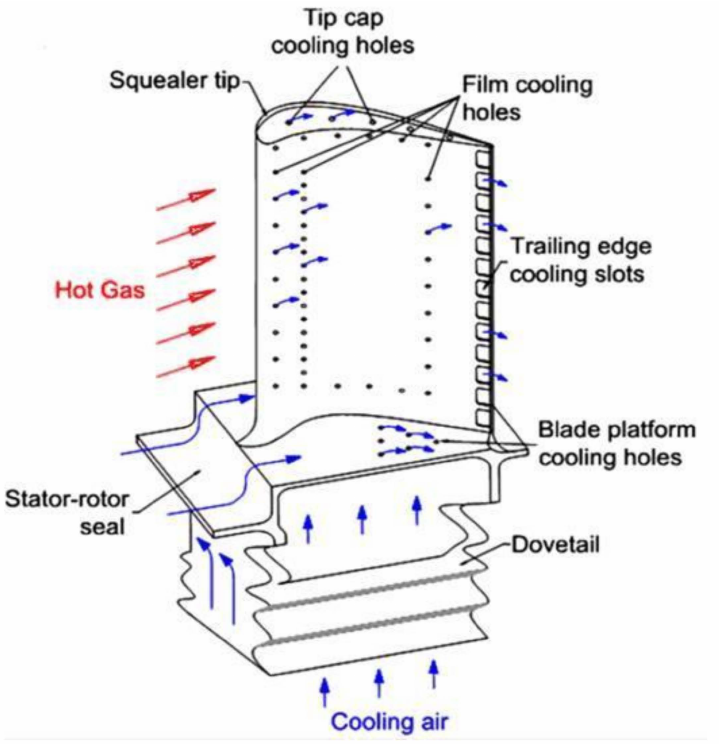
Figure 12. Gas turbine blade cooling schematic